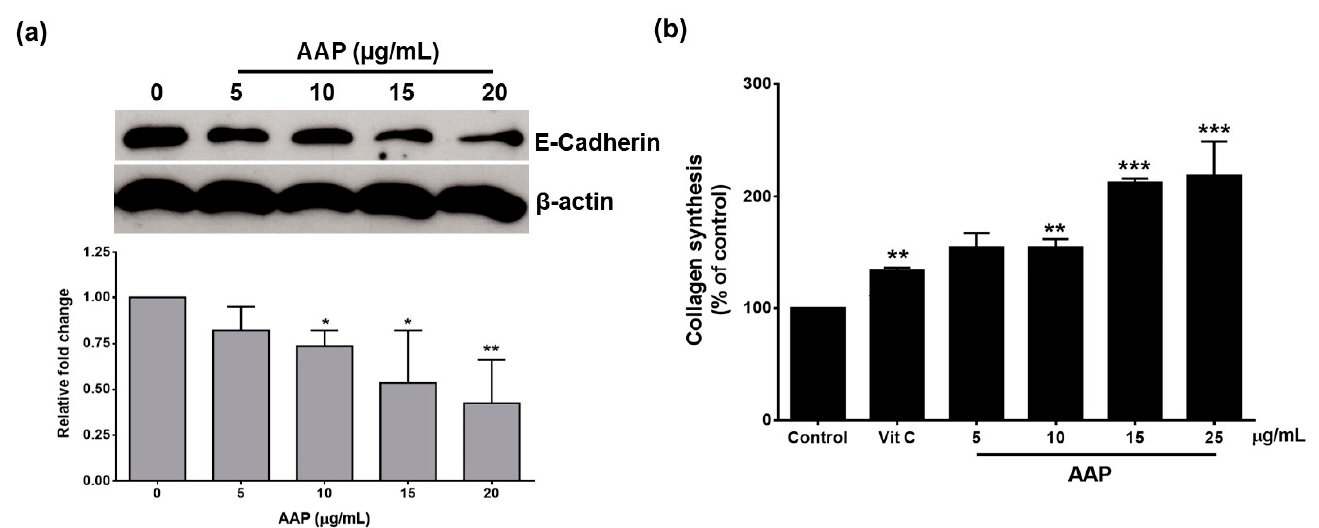
Figure 5. AAP decreased E-cadherin expression in keratinocytes and enhanced collagen synthesis in fibroblasts. The E-cadherin expression ( a ) in keratinocyte cells after AAP treatment for 24 h was determined by Western blot analysis. The bands were normalized to β -actin as a loading control. The quantification level of protein expression was determined by IMAGE J software. Collagen synthesis ( b ) was determined using a Sirius Red Collagen Detection kit. Human fibroblasts were starved in serum-free medium for 24 h. Cells were then treated with various concentrations of AAP (0–25 µ g/mL) for 48 h. Data are presented as mean ± S.D. values of three independent experiments, ** p < 0.01 and *** p < 0.001 vs. control .